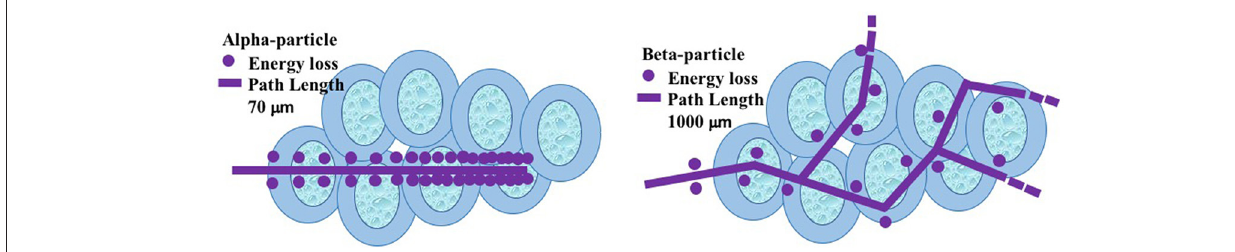
FIGURE 1 | Path lengths of alpha- and beta- particles at target site.